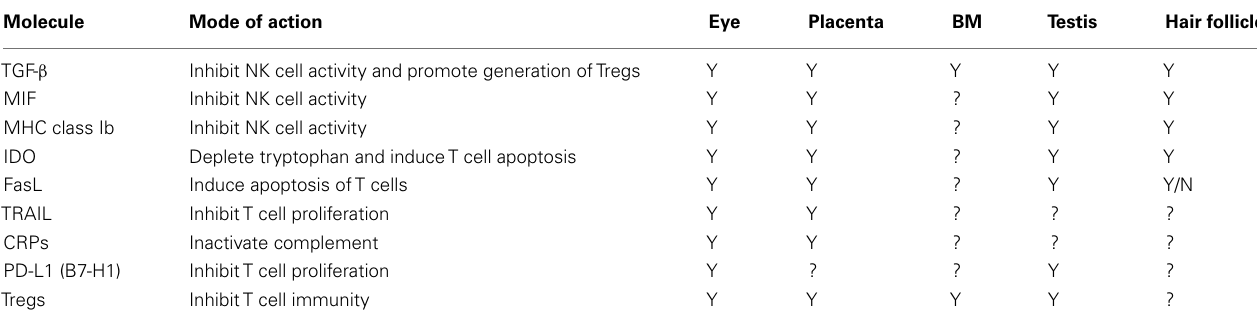
Table 1 | Factors that contribute to immune privilege in the eye and in sites of stem cell residence. Molecule Mode of